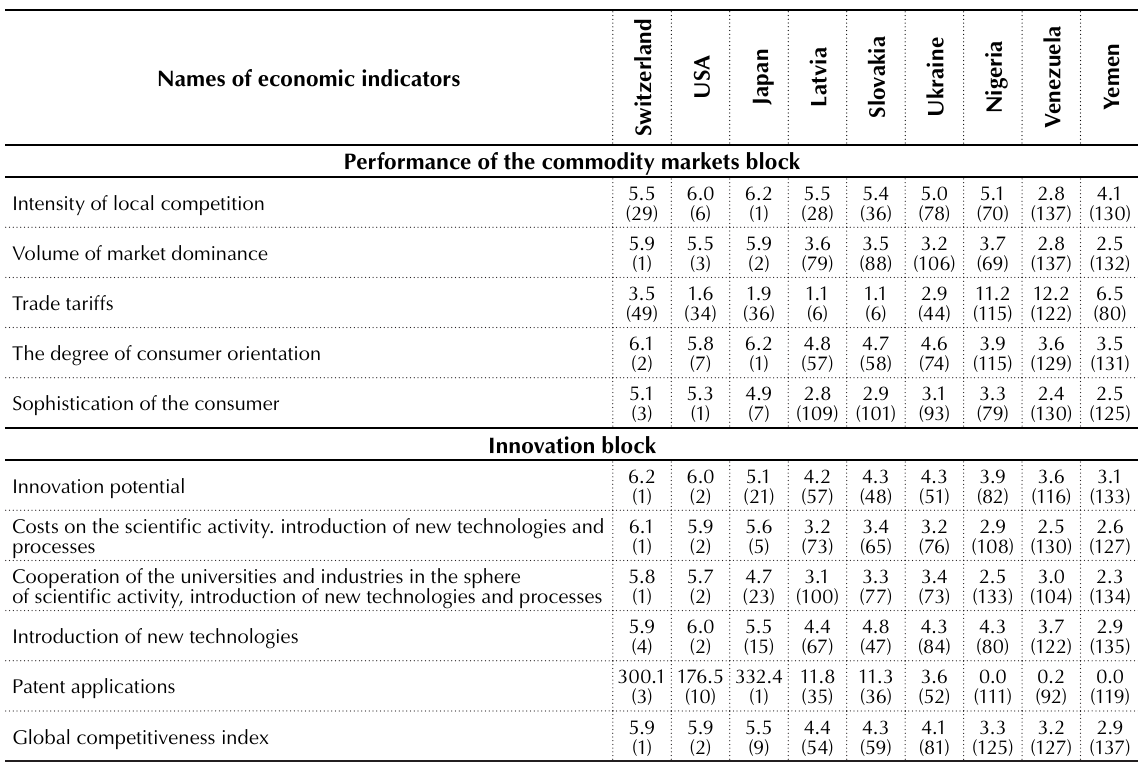
Table 1. Comparative analysis of the global competitiveness of the countries across the world in 2017,